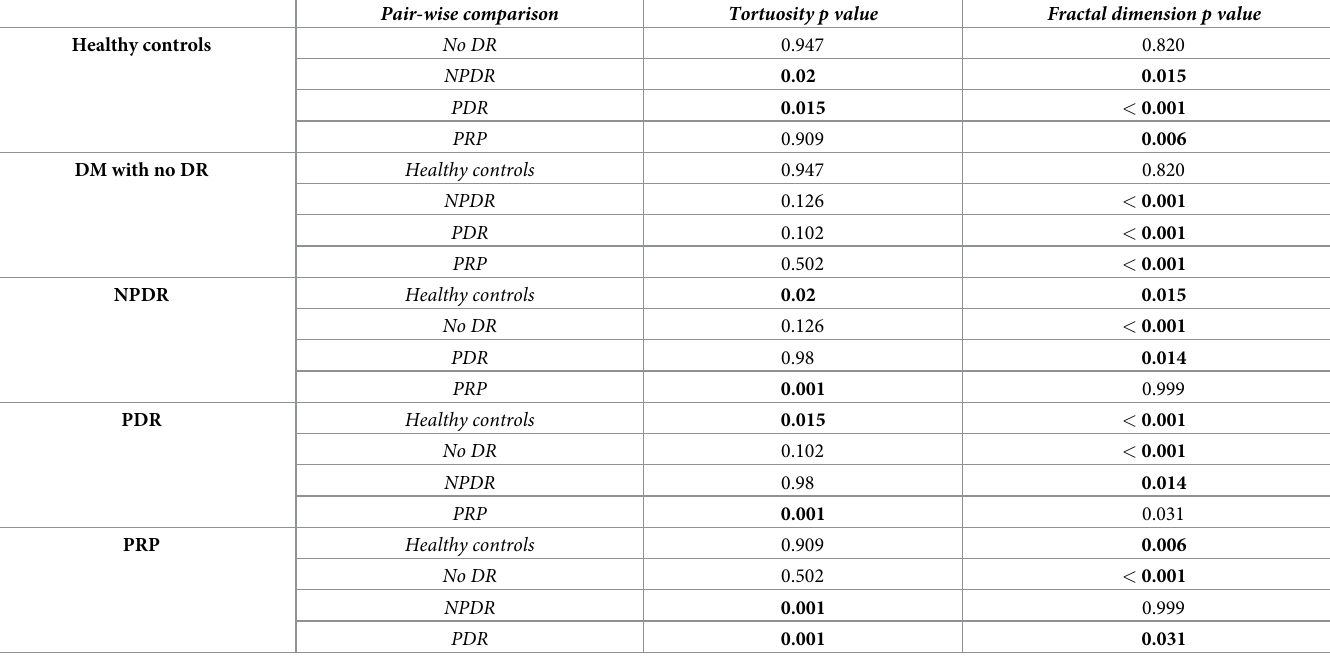
Table 2. Post-hoc analysis of vessel tortuosity and fractal dimension results comparing the five